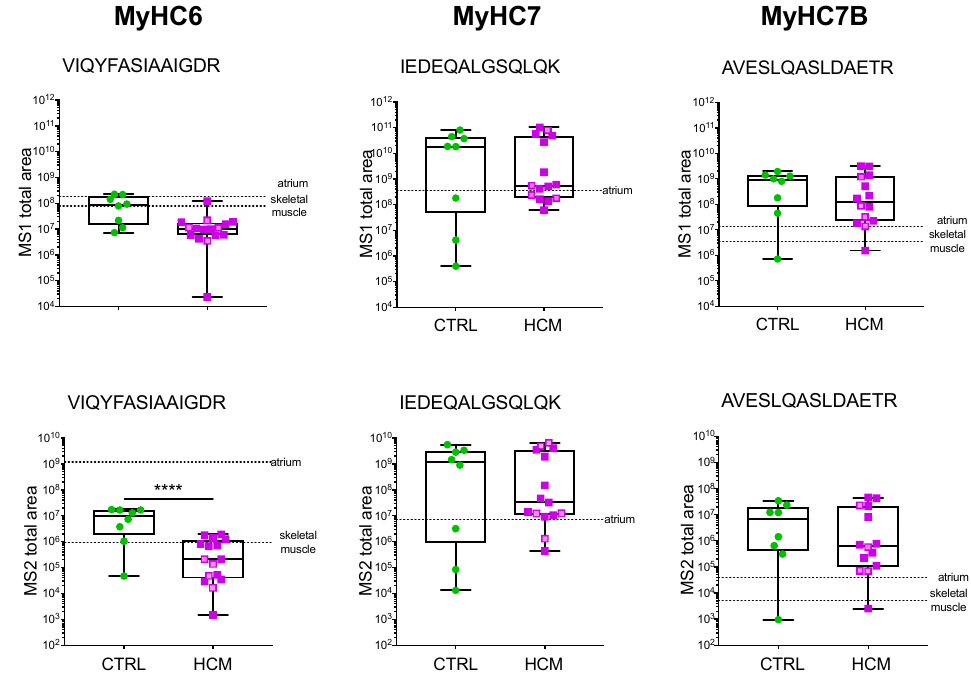
Figure 1. Myosin protein analysis by MS. PRM quantification of myosin isoforms in HCM (n = 14) and CTRL (n = 8) is presented as MS1 and MS2 total area of representative selected peptides. The HCM patients without HCM-associated mutations are presented in violet, and those bearing mutations are presented in pink. Two additional morphologically normal human samples, from atrium and skeletal muscle biopsies, serve as comparators (dotted lines). Mean values from technical replicates/samples are presented as dots and boxes (min to max). Unpaired t -test was applied; significant differences with p < 0.0001 are indicated by ****.